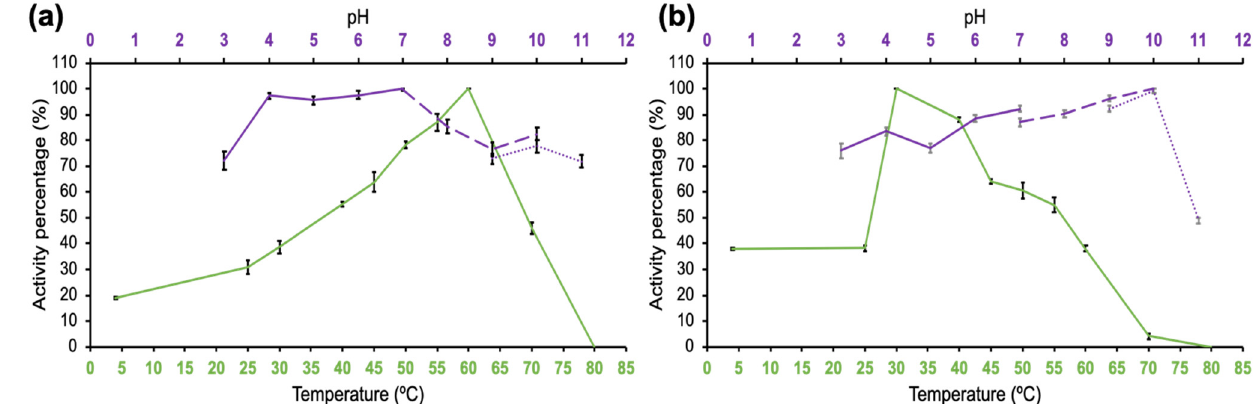
Figure 3. Effects of temperature and pH on β -xylosidase SRBX1 from S. reilianum . ( a ) Optimal tem- perature and pH. ( b ) Temperature and pH stability. Green line: temperature. Purple line: pH. Solid line: McIlvaine buffer (pH 2–7); dashed line: Tris–HCl buffer (pH 7–10); and dotted line: glycine– NaOH buffer (pH 9–11.0). Table 2. Activity of β -xylosidase SRBX1 from S. reilianum against different substrates.